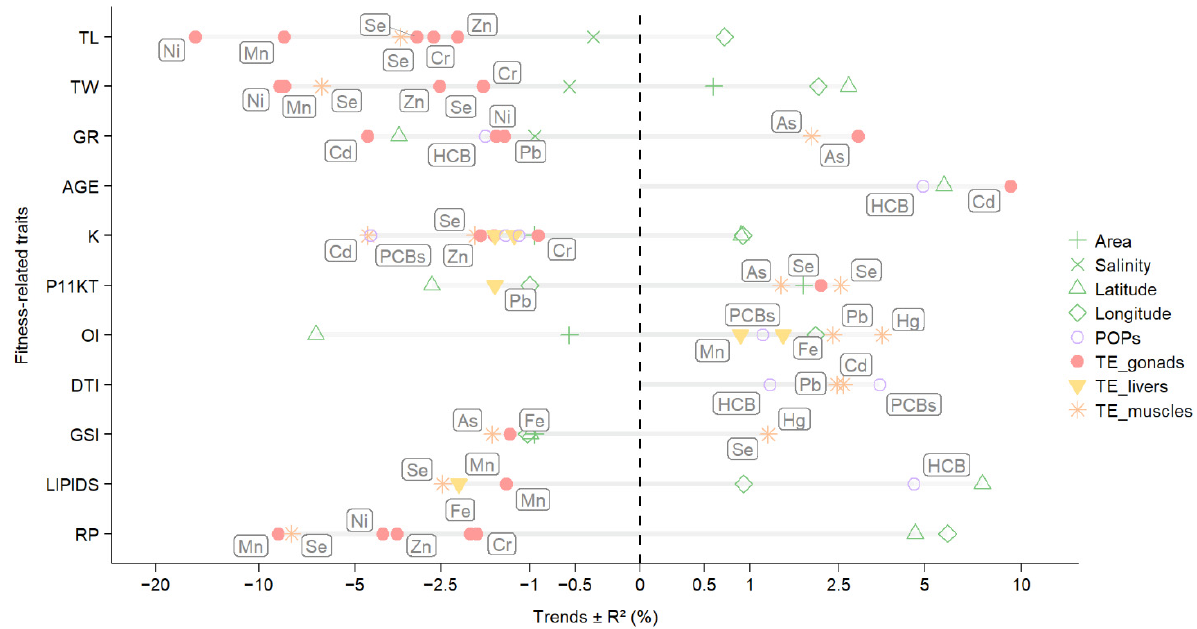
Figure 4. Trends between life history traits of 75 female silver eels and the geographic and contaminants predictors (GCP models). The significant predictors (POPs: persistent organic pollutants, TEs: trace elements) were distributed throughout their explained pseudo-variance gradients (R², %), that signs were assigned by tendencies of the marginal effect of each predictor on traits. The name of the significant contaminant predictor is displayed at each point. The local (catchment) effect was not reported.